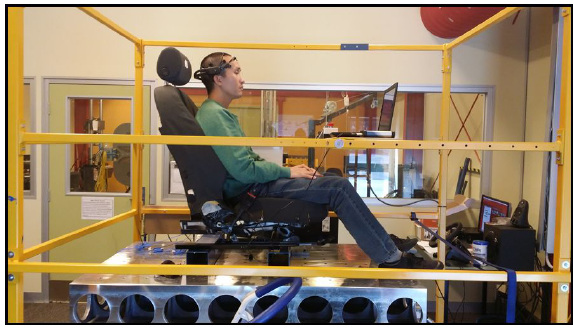
placed at the corner of the table. The off-centre location provides multi input vibrations to the table. An actual ve- hicle seat was chosen and mounted onto the